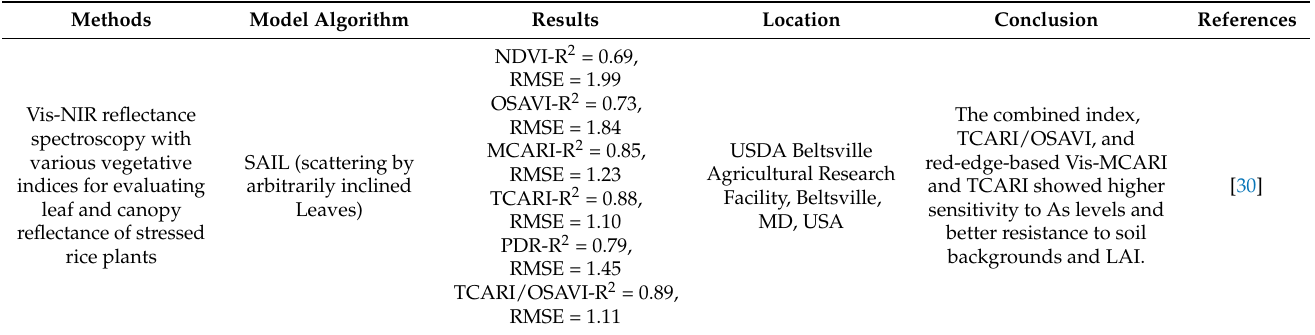
ination monitoring for rice paddy fields along with As-related plant stress. Table 5. Review of hyperspectral reflectance approach in soil As contamination of paddy field along with rice